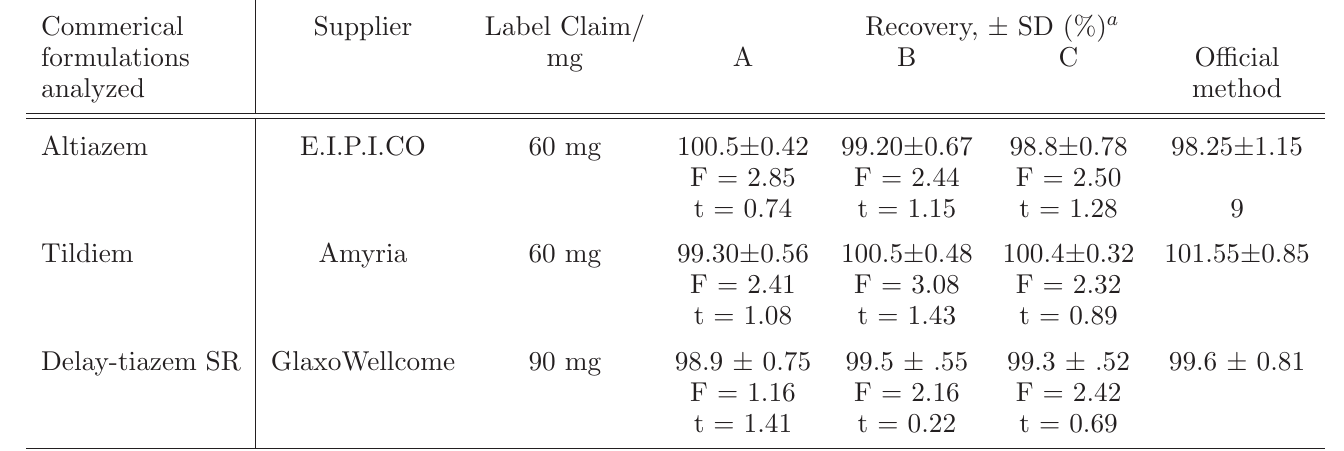
Table 3 Determination of DIL.HCl in dosage forms by the proposed